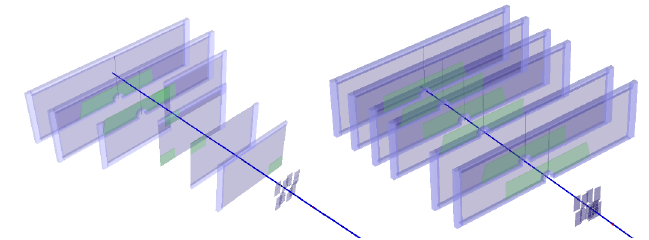
Based on the analysis of the experimental data collected in the deuteron run, the central tracker was extended with two-coordinate planes of a forward silicon detector designed to improve the primary vertex reconstruction [9]. One silicon plane was operated in the carbon run (March 2017), two extra silicon planes were installed in the latest run with the argon and krypton beams in March 2018. The GEM tracker was upgraded to six large area detectors. The central tracker configuration was tuned to measure soft decay products of strange V0 particles. The positions of the GEM and silicon detectors were optimized using Monte-Carlo simulation. The central tracker configurations in the recent runs are shown in Fig. 3.